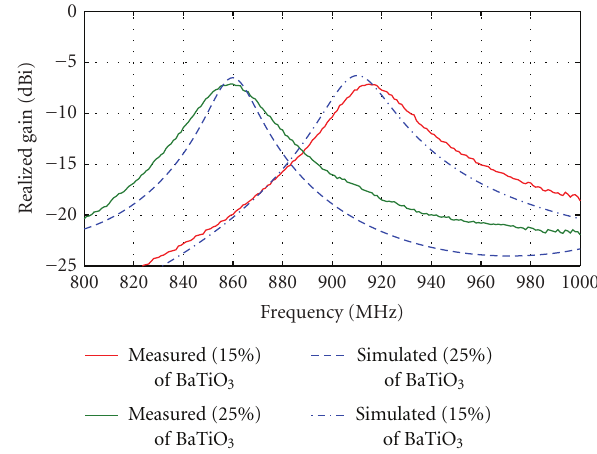
Figure 12: Simulated and measured realized gain in “+ z ” direction of the tag antenna with 15% and 25% of BaTiO 3 concentration in the composite